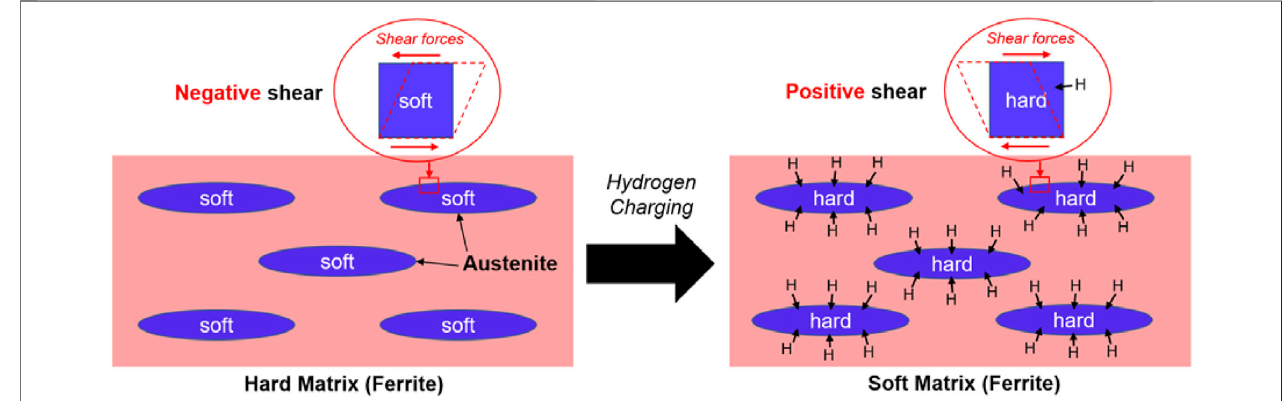
FIGURE17| Schematicmodelexplainingthechangeofthesheardeformationbehaviourfromnegativetopositiveduetoabsorbedhydrogeninthemicrostructure. The austenite phase absorbs most hydrogen and therefore hardens more than the ferrite phase. Soft means it is more compliant to dislocation activities than hard.